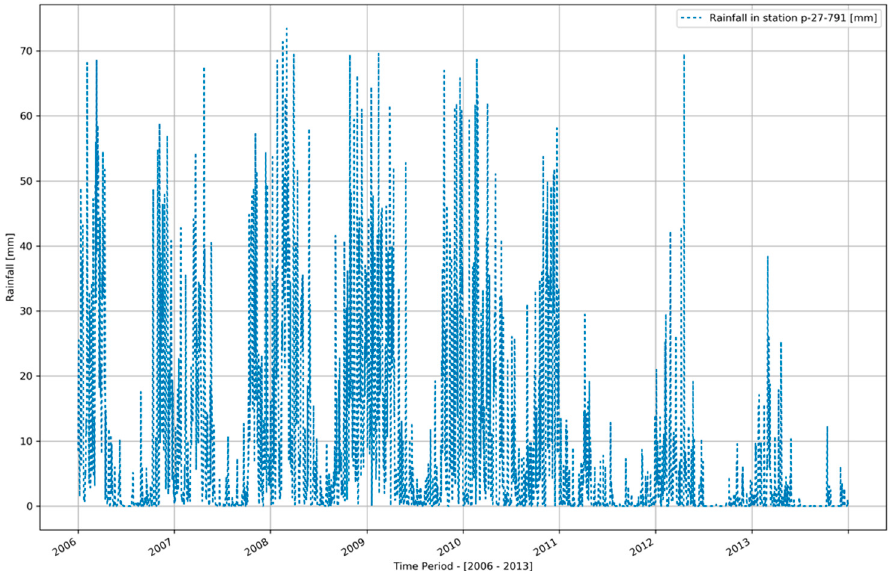
Figure 3. Daily rainfall observations for the period 2006–2013 in the Machángara Basin. Source: ARCSWAT simulation [9].